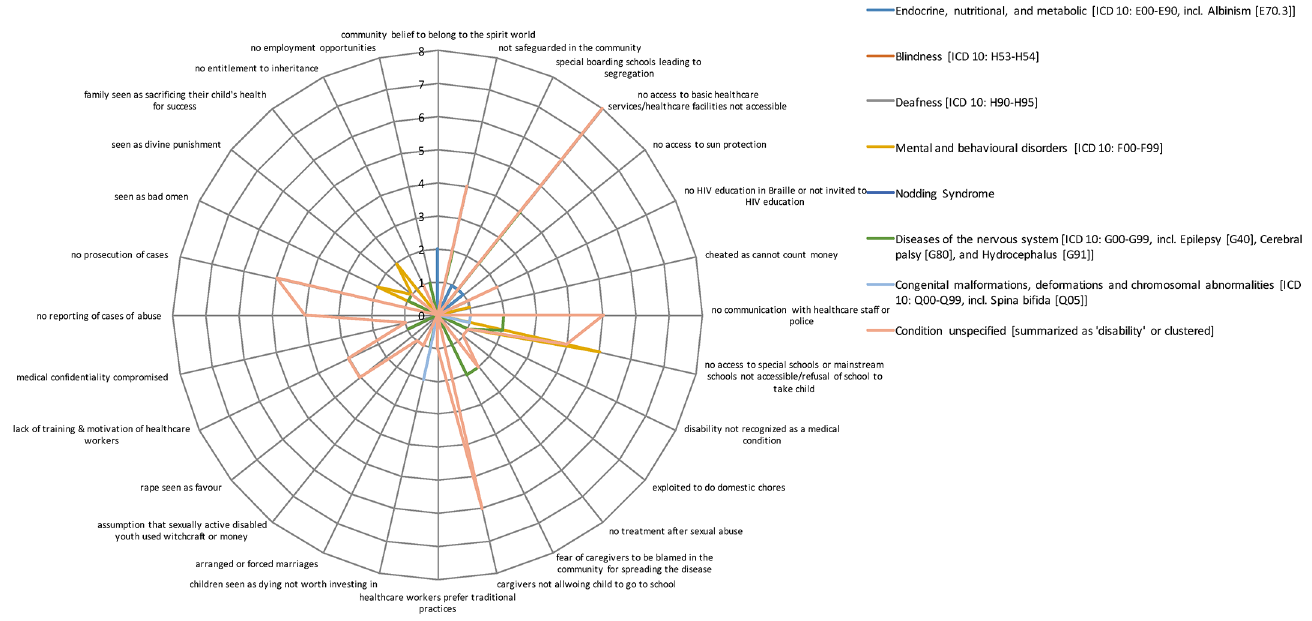
Fig 8. Evidence of systemic abuse by type of